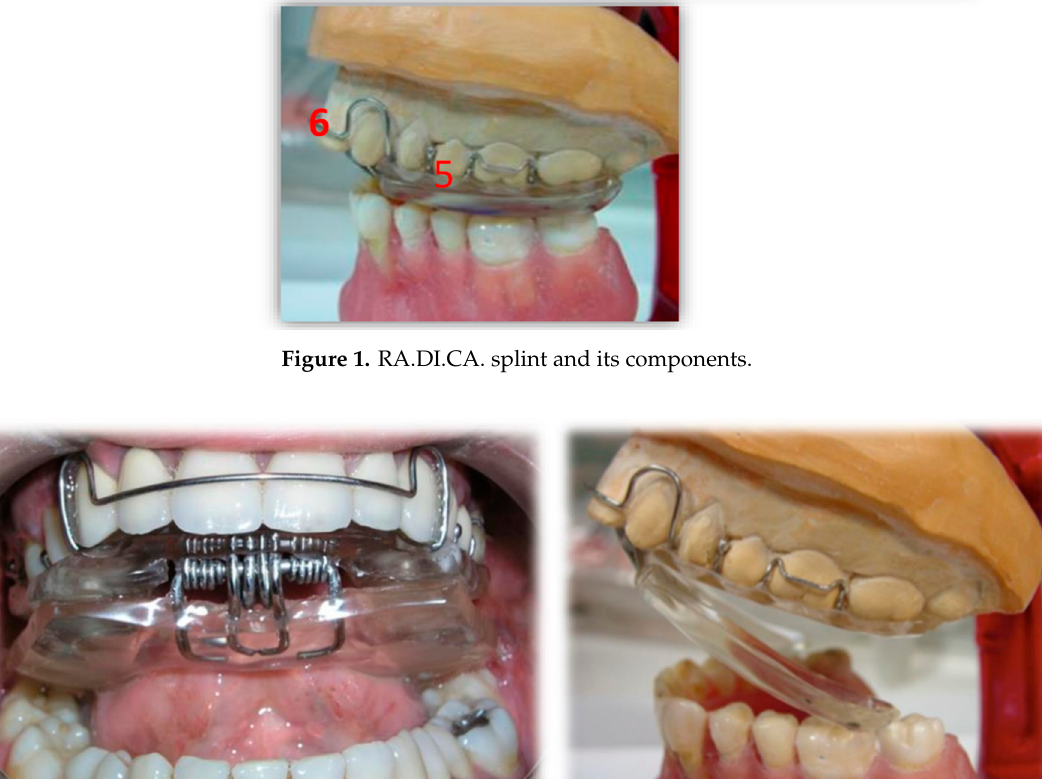
Figure 2. RA.DI.CA., mechanism of action (frontal and lateral view).